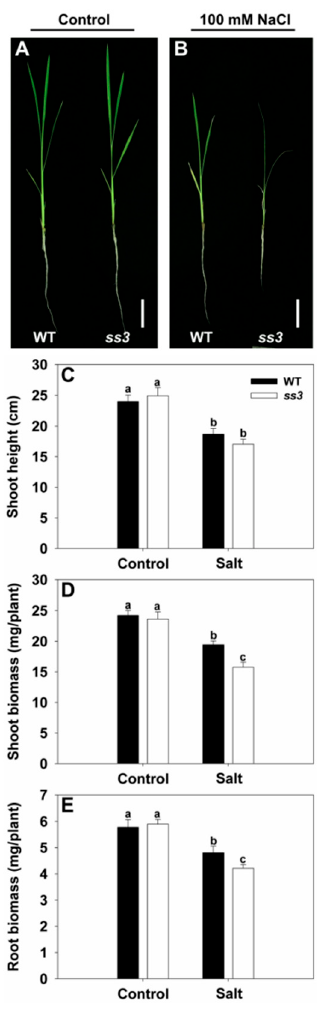
Figure 1. Growth performance in response to salinity stress of ss3 mutant compared with WT. Growth performance of WT and ss3 mutants under normal ( A ) or 100 mM NaCl treatment ( B ). Ten-day-old seedlings were treated for four days with or without the addition of 100 mM NaCl. Shoot height ( C ), shoot biomass ( D ), and root biomass ( E ) of the seedlings under normal and salt stress conditions. Bars = 4 cm. The values are means ± SE of five replicates. Significant differences at p < 0.05 are indicated with different letters.